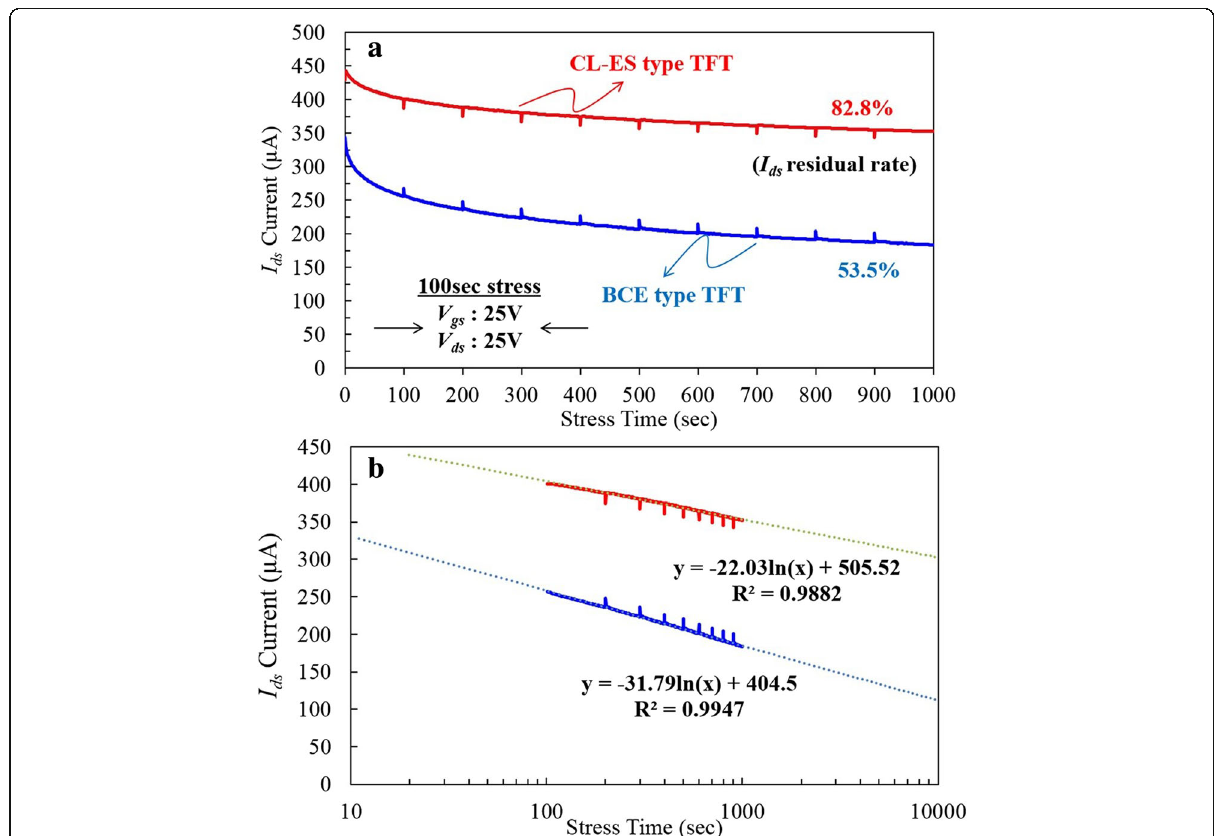
Fig. 6 a Experimental data for 1000 s and b extrapolation for long-term HCS evaluation of the CL-ES- and BCE-structured GOA